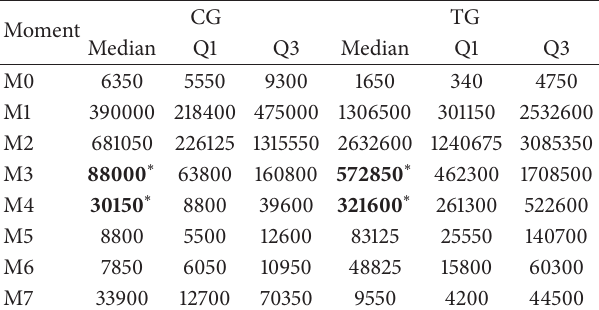
Table 2: Comparison of the total peritoneal RBC count between the control (GC) group and the treated group (TG) at different times (RBCs/ 𝜇 L).